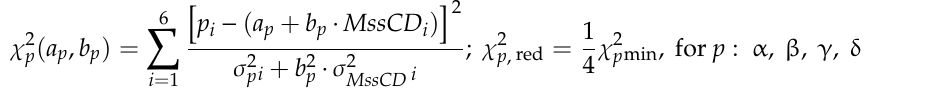
Figure 8. (Left) Diagrams of the modified p -value and reduced chi-square characterizing the linear fitting of the parameters α (a) , β (b) , γ (c) , and δ (d) , with MßCD plotted, as a function of the multiplication factor (M.F.). We identify the M.F. value, for which the corresponding p -value and reduced chi-square are optimized. The goodness of fit is shown using both the modified p -value and reduced chi-square. (Right) Here, the goodness of fit is shown using the unified measure as given by Equation (9) while it is depicted as a function of the signal-to-noise ratio of the slope b/ δ b , characterizing the linear fitting of the parameters with MßCD; (note: Both the ratio b/ δ b and the goodness of fitting are plotted as functions of the multiplication factor (M.F.)). The cases of the parameter α and γ have the optimal values of the p -value and reduced chi-square for │ b/ δ b │ < 1, so that the hypothesis of being dependent on MßCD is rejected. On the other hand, the cases of the parameter β and δ have the optimal values of the p -value and reduced chi-square for │ b/ δ b │ >> 1, thus, the hypothesis of MßCD dependence is accepted.